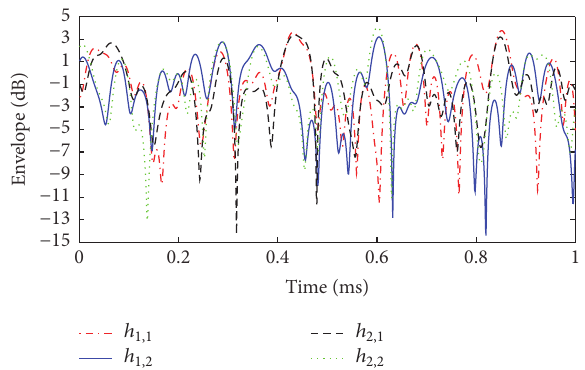
Figure 8: Envelopes of four subchannels generated by using the proposed simulation